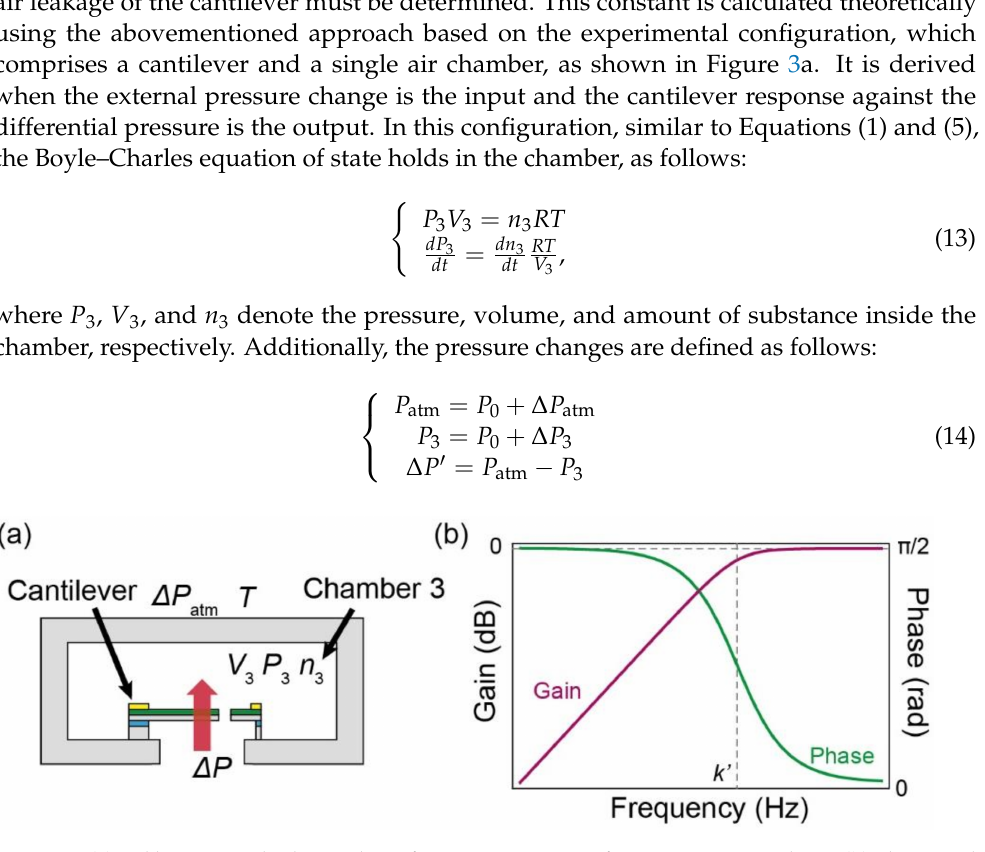
Figure 3. ( a ) Calibration method to evaluate frequency response of piezoresistive cantilever. ( b ) Theoretical frequency characteristics based on